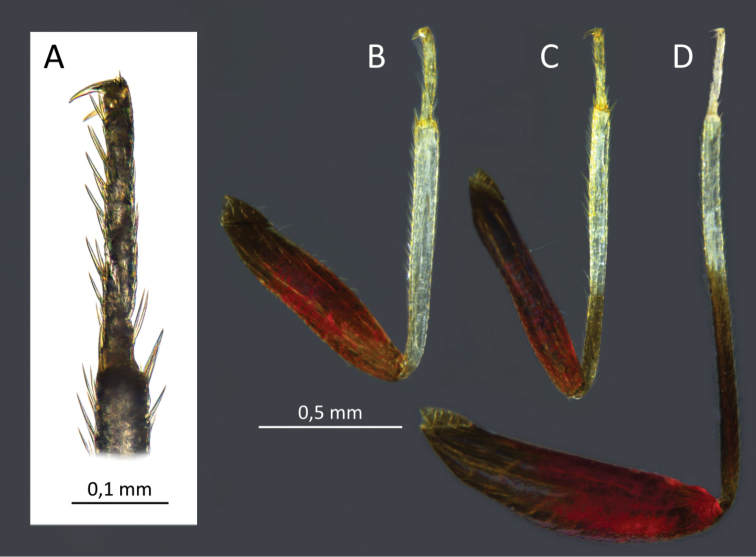
S.henryi, male, 1st leg tarsus (A), legs: 1st (B), 2 nd(C), 3th(D).